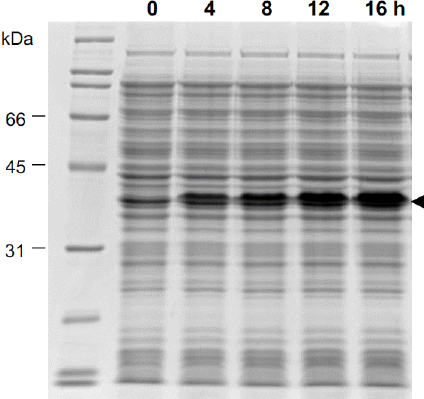
Figure 3. TEVK protein expression time course in E. coli . Cells were grown in Terrific broth (modified) and protein expression was induced with 1.0 mM IPTG at 20 °C and analyzed by SDS-PAGE at 0, 4, 8, 12 and 16 h.